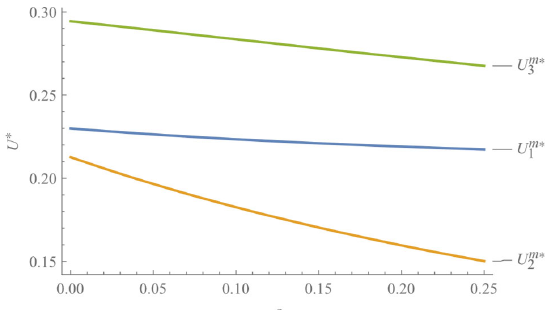
Fig. 3. The impact of the manufacturer's risk aversion on the manufacturer’s utility